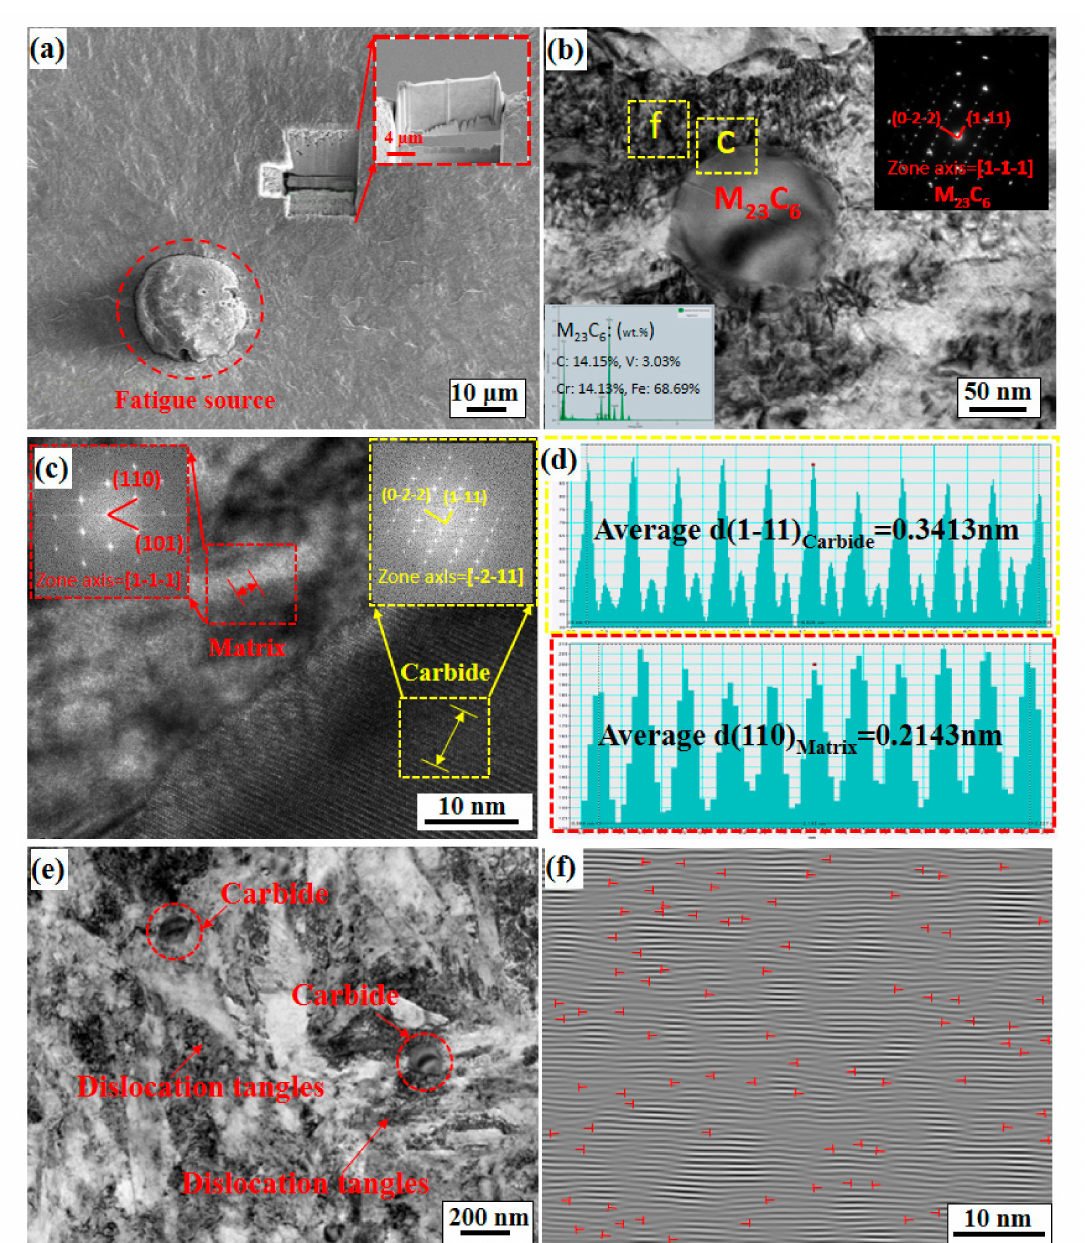
Figure 10. Microstructure image of the results of the axial fatigue test ( σ = 870 MPa, A = 0.521 and N f = 5.45 × 10 6 cycles): ( a ) sampling location of SEM-FIB; ( b ) TEM image of M 23 C 6 carbides; ( c ) HRTEM images and the corresponding Fourier spot for region c in ( b ), suggesting that the relationship between the M 23 C 6 precipitate and the matrix follows the [-2-11] M23C6 //[1-1-1] bcc-Fe orientation relationship; ( d ) the interplanar crystal spacing of the (1-11) M23C6 phase and (110) α -Fe , respectively; ( e ) TEM image of the microstructure of the fisheye area; and ( f ) the corresponding FFT pattern for region f in ( b